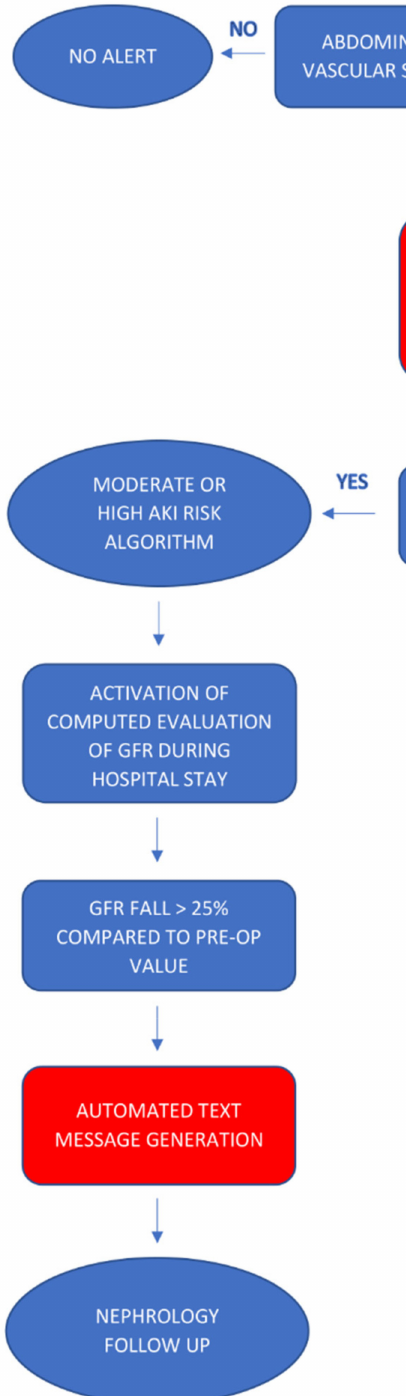
Figure 1. Algorithm for generating an automated electronic